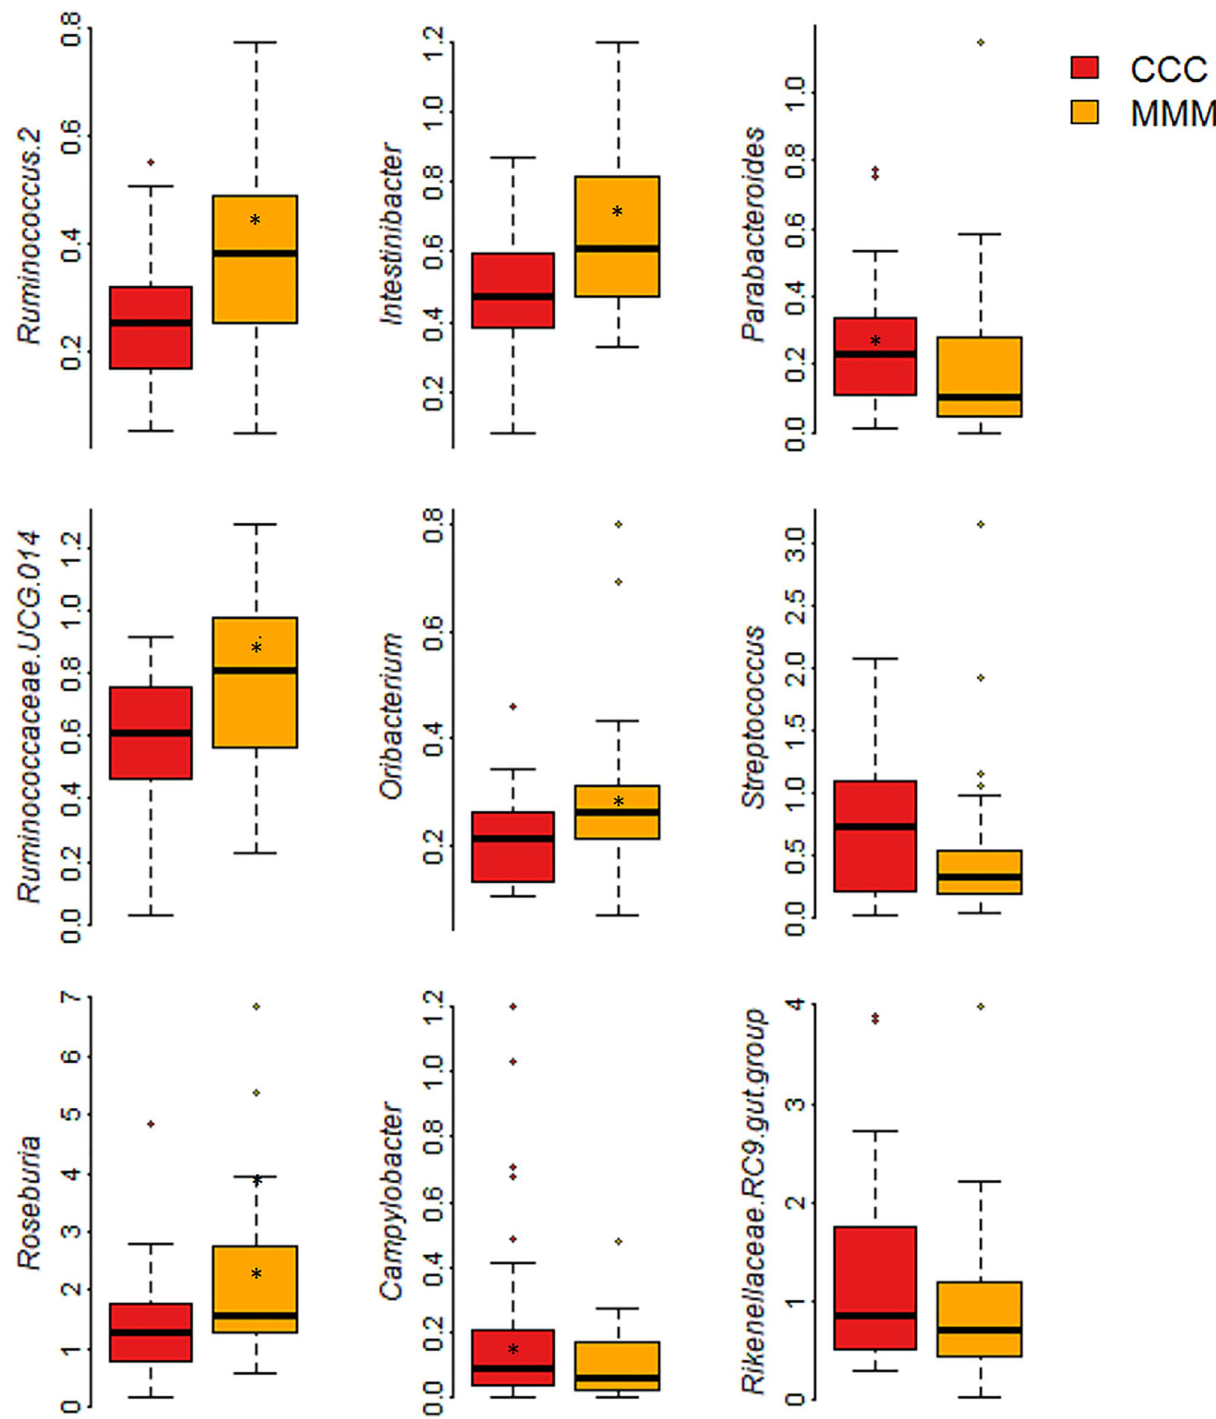
Figure 5. Relative abundances of microbiota between control (CCC), and MFC (MMM) piglet groups at genus level. Asterisks indicate significant differences (p <